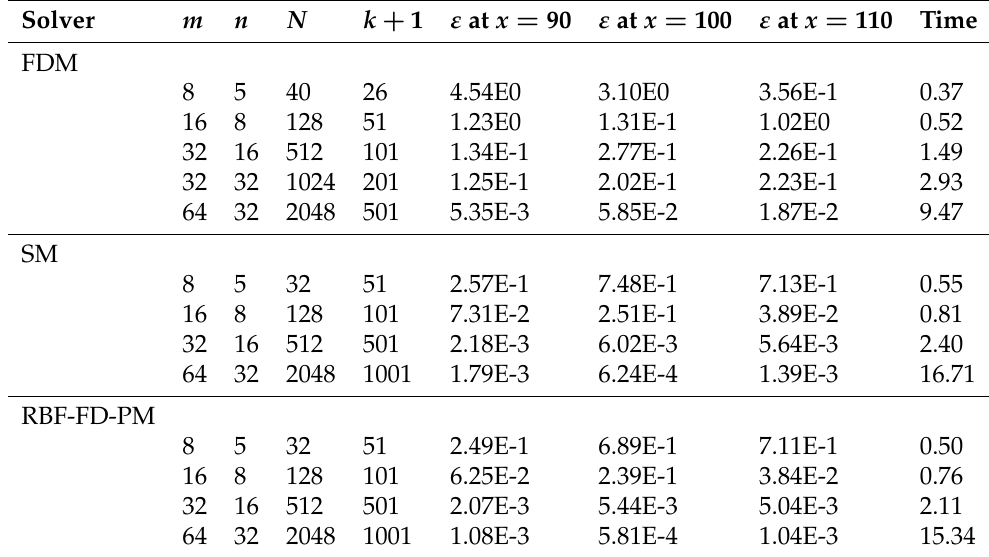
Table 2. Numerical results of the different solvers in Example 2.